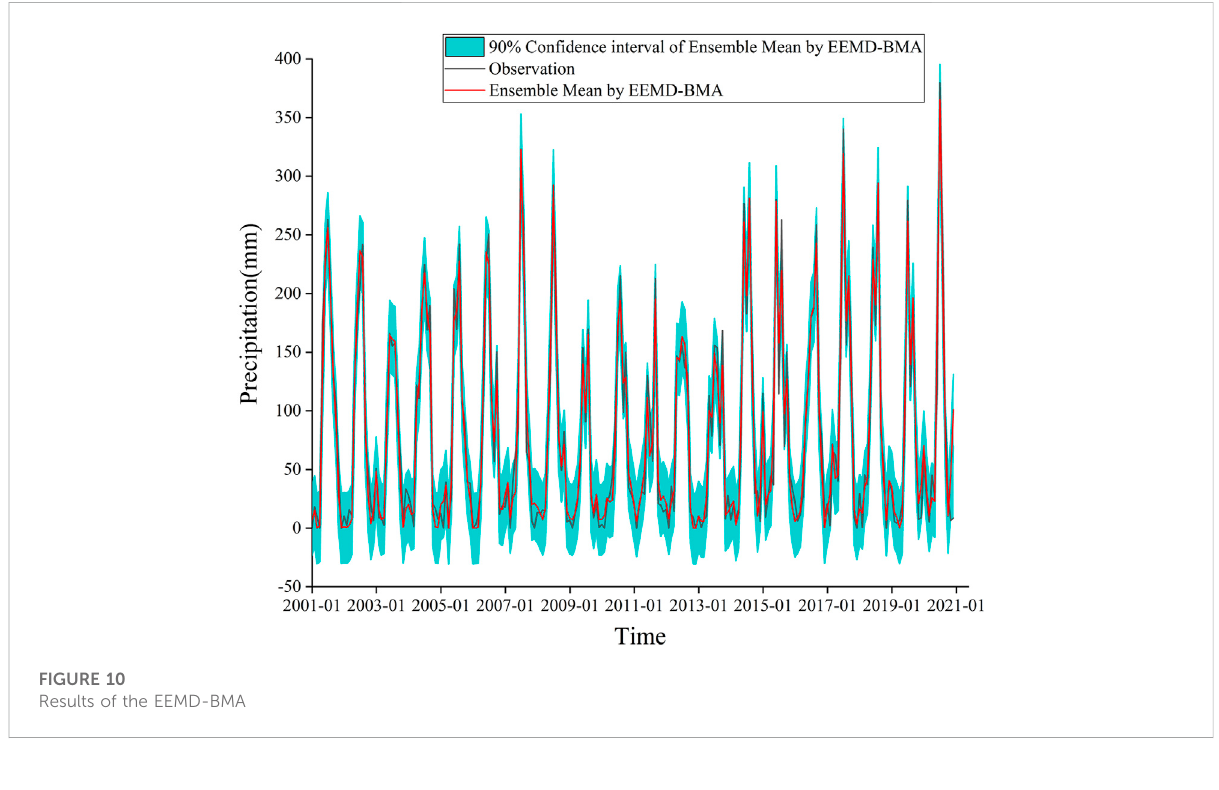
FIGURE 10 Results of the EEMD-BMA